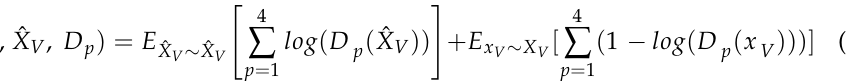
Figure 4. The architecture of the multiscale patch discriminator. The rectangle stands for the convolutional block in the feature extractor, and the arrowheads with different colors stand for the different convolutional blocks for getting final feature maps with different sizes.